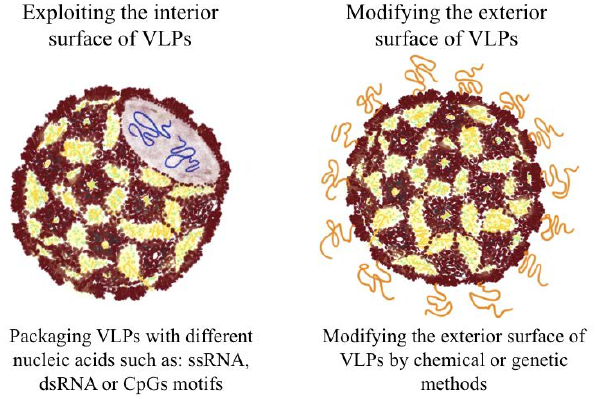
Figure 1. A schematic diagram of nucleocapsid-derived VLPs illustrating some modifications that can enhance their immunogenicity. (1) packaging of nucleic acids and (2) displaying heterologous proteins/epitopes or functional molecules on the outer surface.